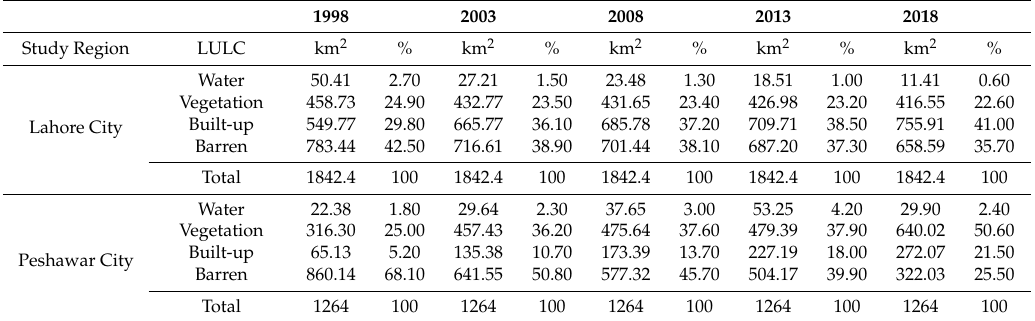
Table 3. LULC in two major cities of Pakistan.